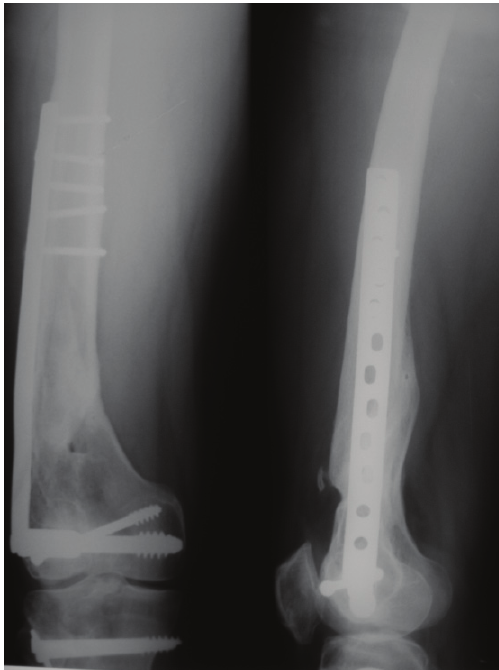
Figure 7: X-ray right femur AP and lateral views at 2-year followup showing fracture union.